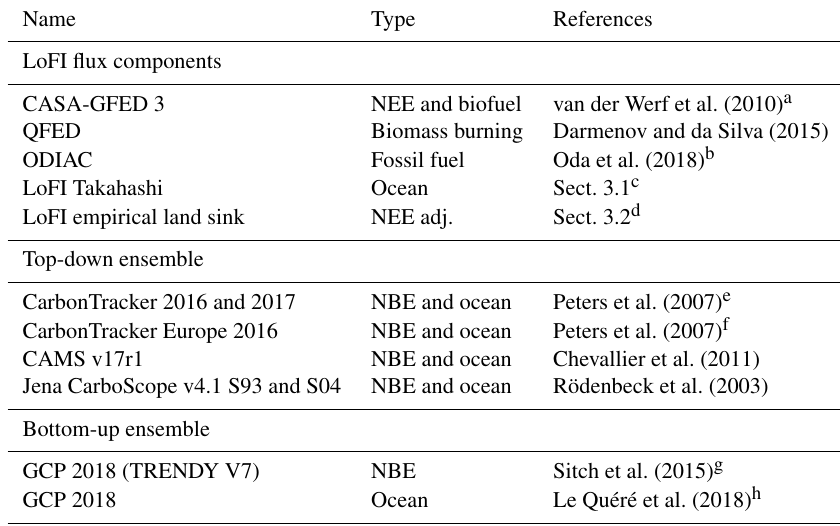
Table 1. The components of our fluxes and the different ensembles used for